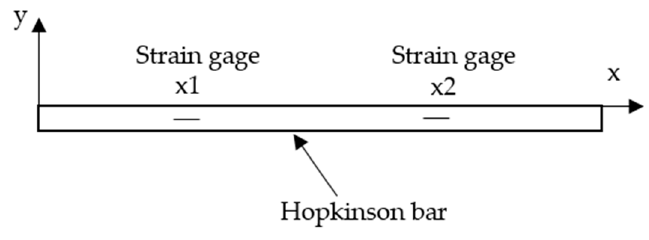
Figure 12. Schematic of elastic bar with two strain gage stations.